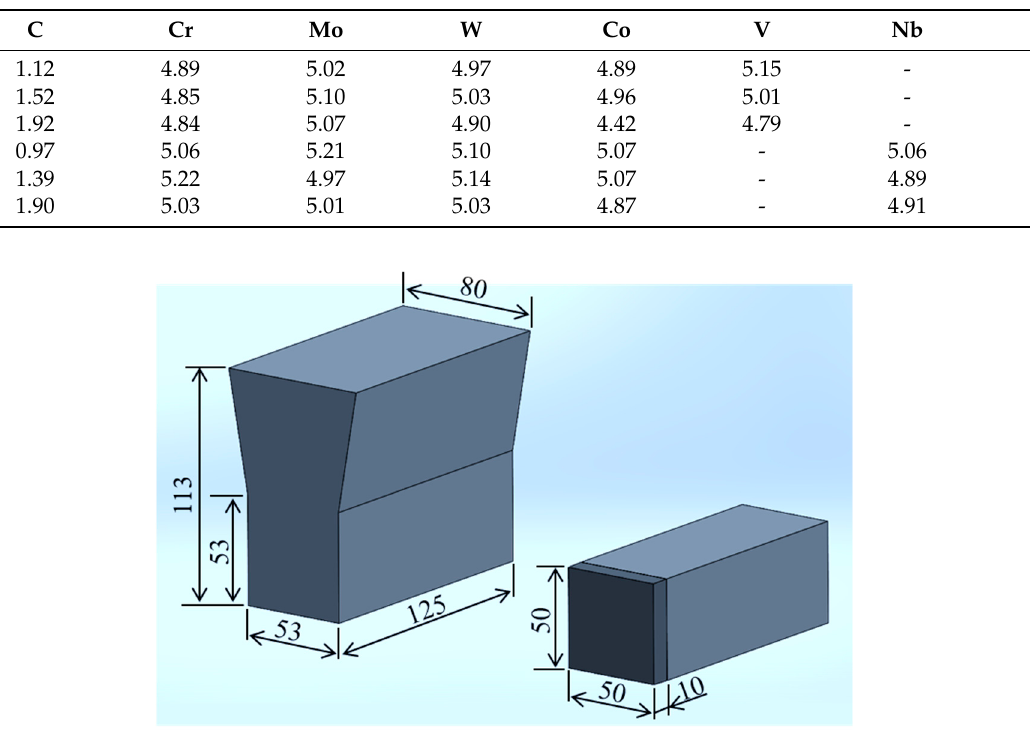
Table 1. The chemical compositions of the studied alloys (wt.%).